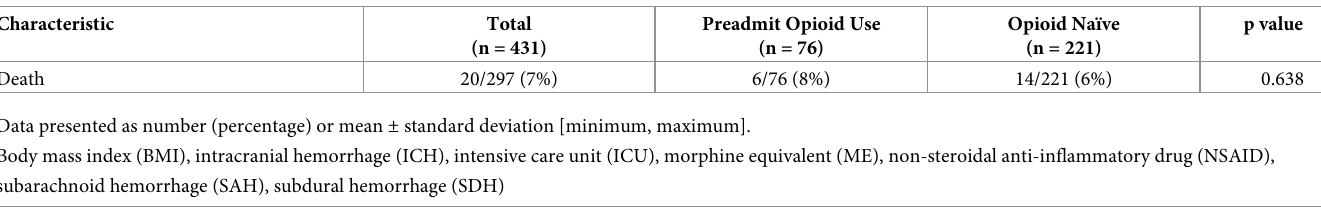
Table 2. Descriptive statistics comparing post-discharge opioid use between preadmission opioid users and opioid na ï ve patients. Medication